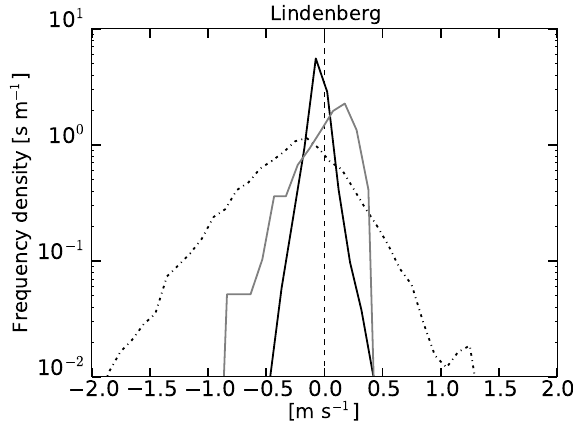
Fig. 8. Case study for Lindenberg, 29–30 January 2008: histograms of vertical velocity for AROME (solid black), observations aver- aged to 2500m scale (solid grey), and observations at their original resolution (black dash-dot line). The vertical dashed line marks the 0 m s − 1 velocity. Note the logarithmic scaling on the vertical axis. The vertical velocity bin width is 0 . 1 m s − 1 for all